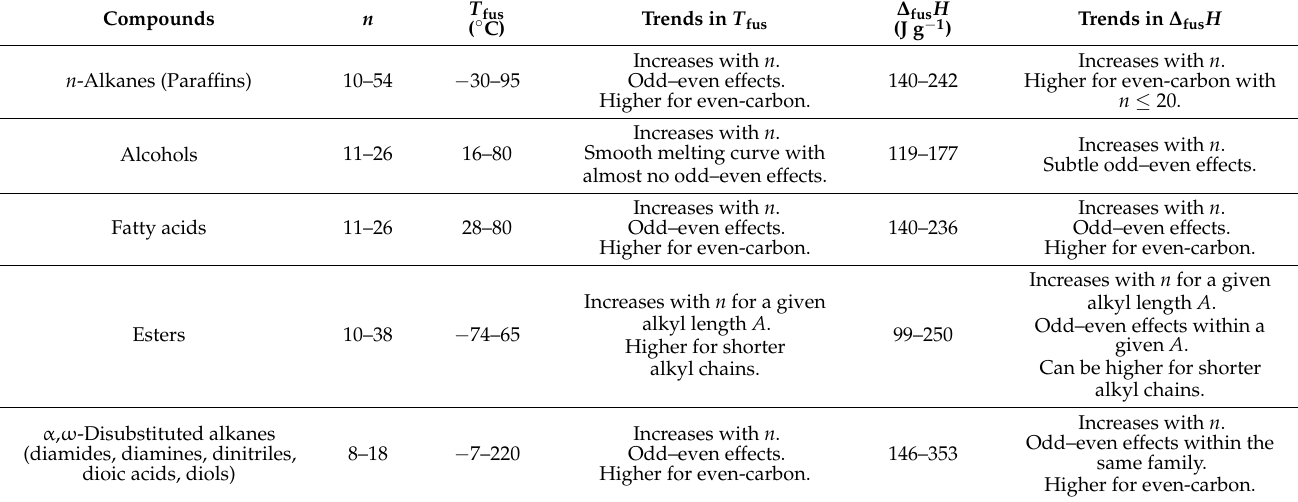
Table 1. A summary of the families of long-chain linear organic compounds reviewed in this work. For each family, the ranges of alkyl chain length, n , and of the melting points ( T fus ) and enthalpies of fusion ( ∆ fus H ) are indicated. Trends in T fus and ∆ fus H observed from this review are also